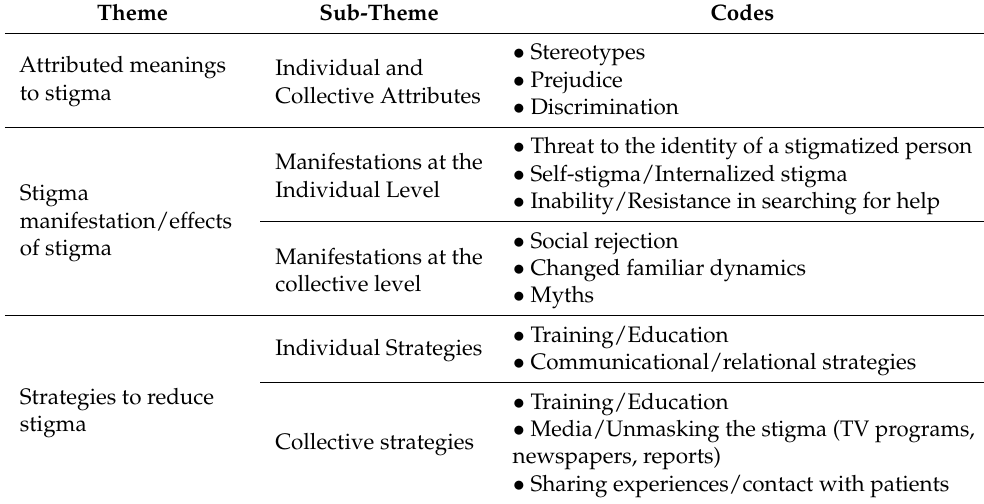
Table 3. Themes, sub-themes and codes emerged obtained from the thematic